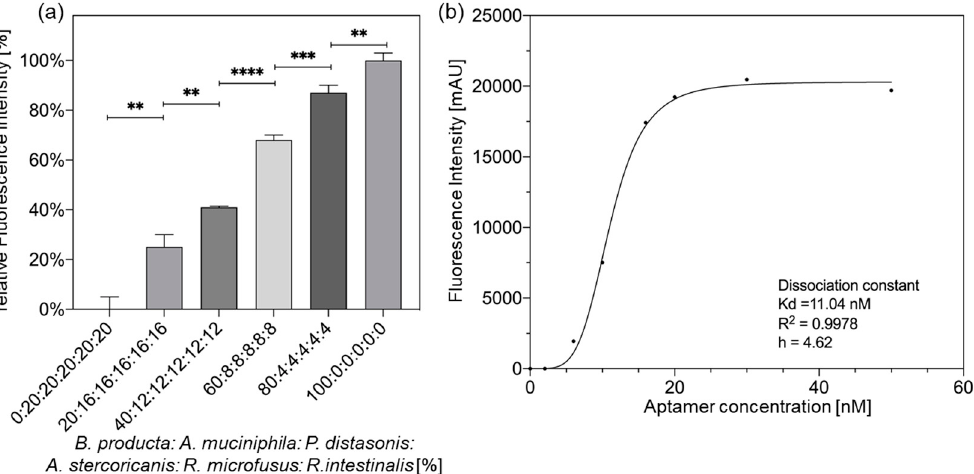
Figure 3. Specific detection of B. producta using the polyclonal aptamer library B.p ‐ R14. ( a ) Detection of B. producta by Cy5 ‐ labeled polyclonal aptamer library B.p ‐ R14 in a mixture of intestinal bacteria including A. muciniphila , P. distasonis , A. stercoricanis , R. microfusus , and R. intestinalis , all mixed at the same optical density but different ratios. p values <0.05 were considered significant. ** indicates